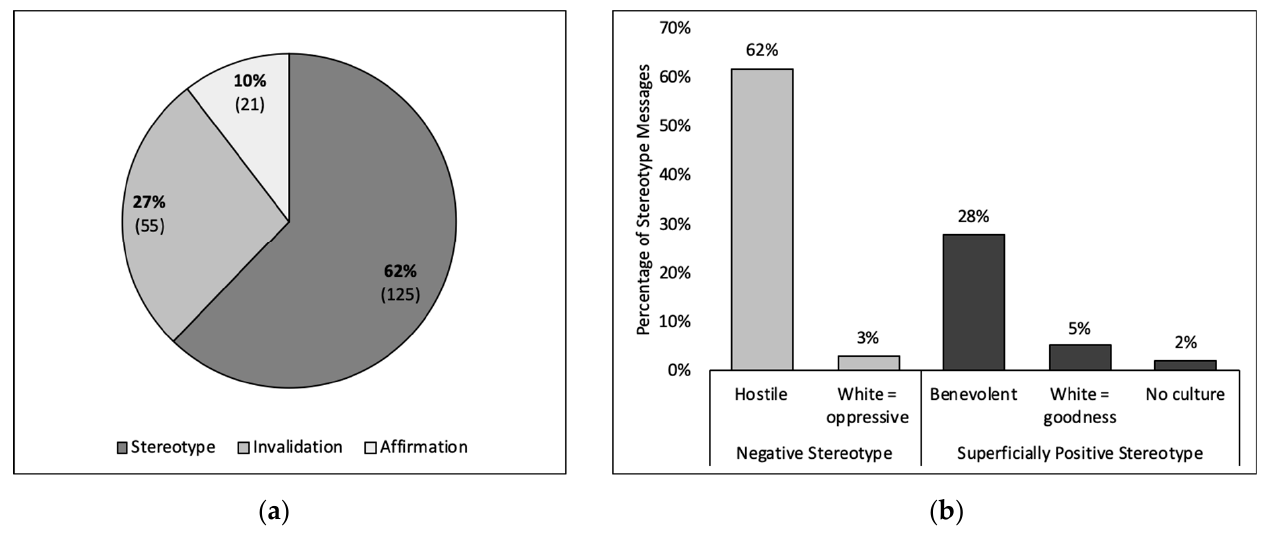
Figure 1. ( a ) Proportion and absolute number of external messages by Message Type ; ( b ) Stereotype message prevalence broken down by subtype. percentages in this figure add to 99% due to rounding error; ( b ) Stereotype message prevalence broken down by subtype.